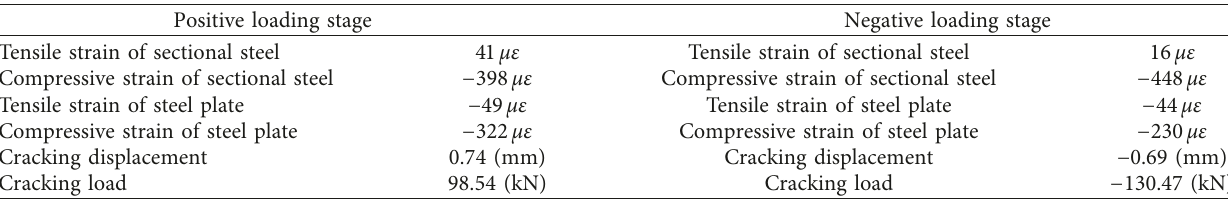
Figure 18: Diagram of cracks in the Δ � 18mm displacement cycle. (a) First cycle. (b) Second cycle. Table 7: Test data of the SPRCW-4 test piece in the load control